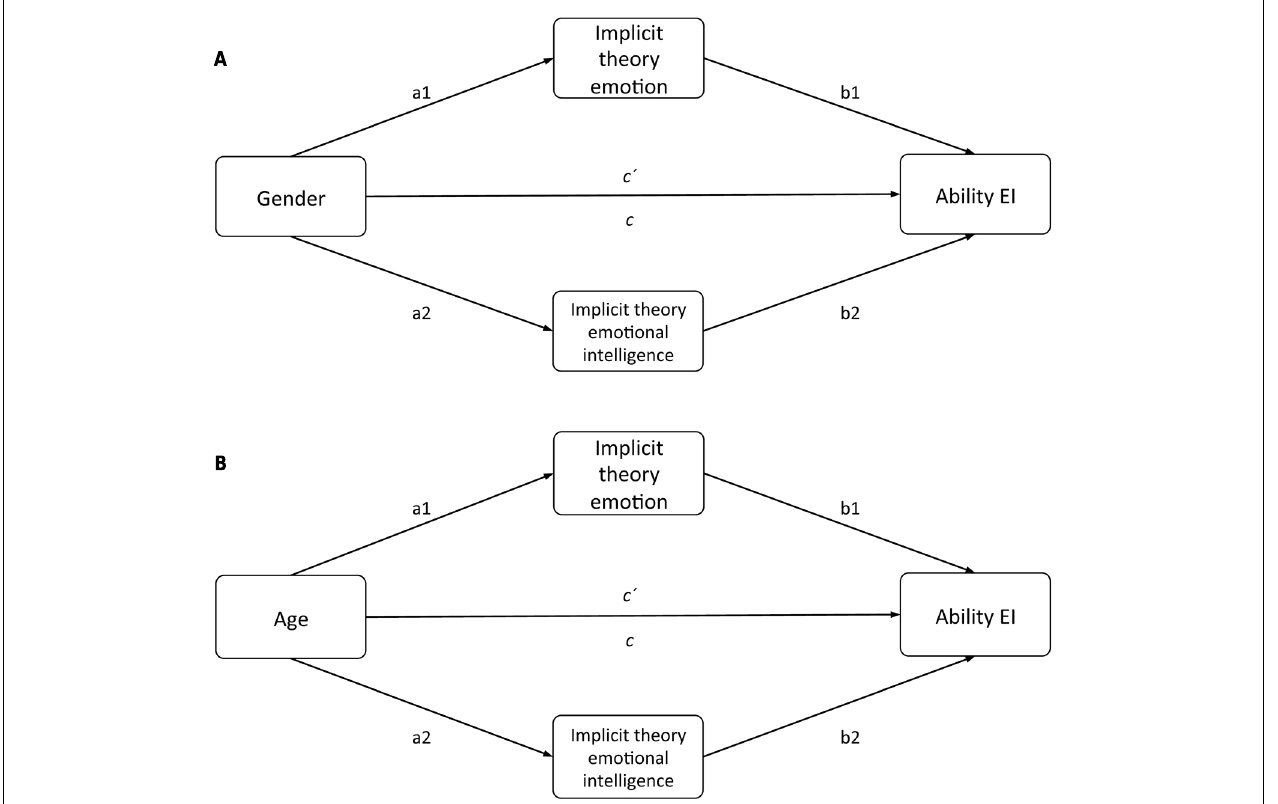
FIGURE 1 | Hypothesized parallel mediation